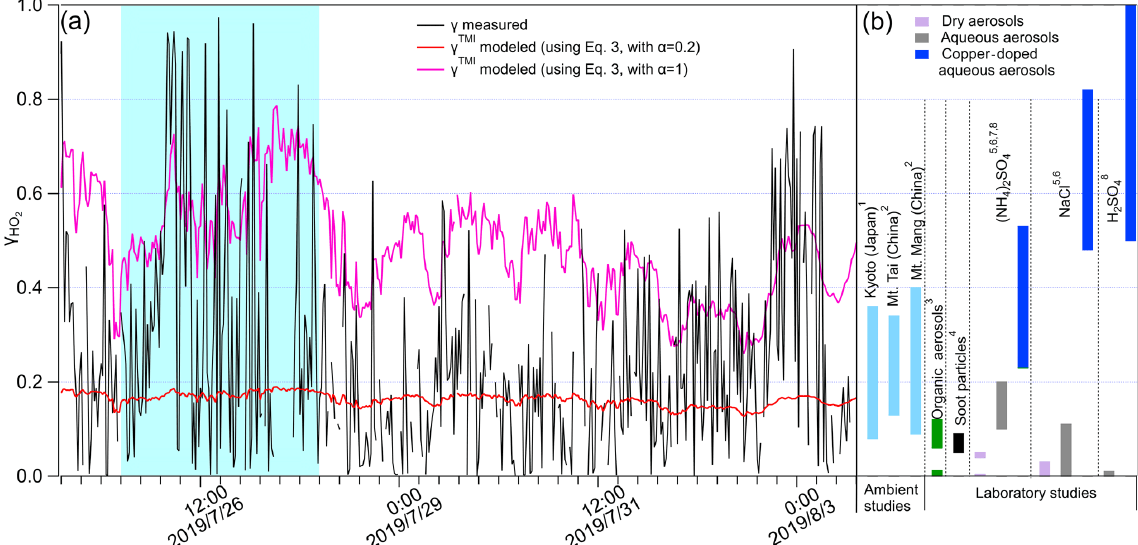
Figure 4. (a) Measured and modeled γ values along with measurement time. The blue shaded area represents group i; the remaining areas represent group ii. (a) HO 2 uptake coefficients onto different types of aerosol obtained from ambient and laboratory studies: the numbers indicate the related references from which the data were obtained: 1. Zhou et al. (2019b); 2. Taketani et al. (2012); 3. Lakey et al. (2015); 4. Bedjanian et al. (2005); 5. Taketani et al. (2008); 6. George et al. (2013); 7. Lakey et al. (2016b); 8. Thornton and Abbatt (2005).